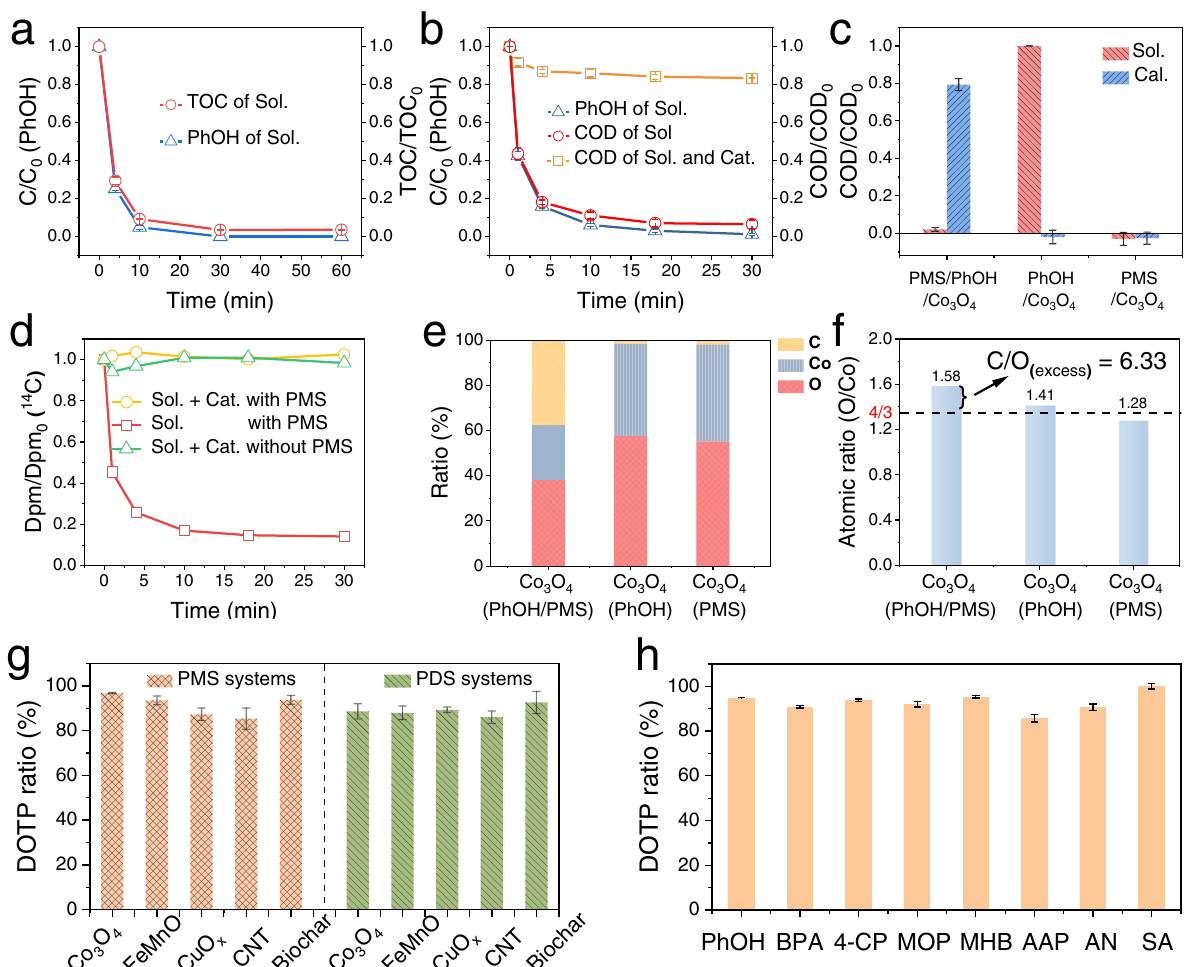
Fig. 1 Removal of organic pollutant and DOTP ratios in the persulfate-based heterogeneous catalytic oxidation systems. a Residual PhOH concentration and corresponding TOC removal in the Co 3 O 4 /PMS/PhOH system at PhOH dosage of 25 mg L − 1 (low-concentration system). b Residual PhOH concentration and corresponding COD removal in the Co 3 O 4 /PMS/PhOH system at PhOH dosage of 250 mg L − 1 (high-concentration system). c Residual COD of the solution and of the catalyst after reaction in the control systems of Co 3 O 4 /PMS/PhOH, Co 3 O 4 /PhOH, and Co 3 O 4 /PMS. d Changes in the radioactivity in the 14 C-PhOH/Co 3 O 4 systems with/without PMS. e EDS analyses of the elemental ratios in the catalyst after reaction in c . f Corresponding O/Co atomic ratios of the Co 3 O 4 in e . g DOTP ratios for the removal of PhOH in the systems with different persulfates and nanocatalysts. h DOTP ratios for the removal of different organic pollutants in the Co 3 O 4 /PMS and CNT/PDS systems. All the dosages of oxidants (PMS and PDS) used above ( a – h ) were twice the molar amount of pollutants. Sol. solution, Cat. catalyst, Dpm. disintegration per minute, C/O excess the atomic ratio of increased C and O on the Co 3 O 4 after the reaction, 2,6-M-PhOH 2,6-dimethylphenol, BPA bisphenol A, 4-CP 4-chlorophenol, MOP guaiacol, MHB methylparaben, AAP acetaminophen, AN aniline, SA sulfanilamide, DOTP ratio the proportion of pollutant removal accomplished via the DOTP reaction DOTP in the representative Co 3 O 4 /PMS/PhOH system. Sig- (Fig. 2d, e and Figs. S16 and S17). The quantitative analysis of ni fi cant accumulation of C-O bond-containing organic products carbon mass loss during thermal decomposition also veri fi ed a on the catalyst surface was con fi rmed by multiple characteriza- complete transfer (~100%) of the pollutants onto the catalyst surface tions, including transmission electron microscopy (TEM), scan- (Fig. 2b and Fig. S18). electron microscopy-energy dispersive spectroscopy (STEM-EDS) mapping, X-ray photoelectron spectro- scopy (XPS), thermal gravimetric analysis-Fourier transform infra- red spectroscopy (TGA-FTIR), and Fourier transform infrared